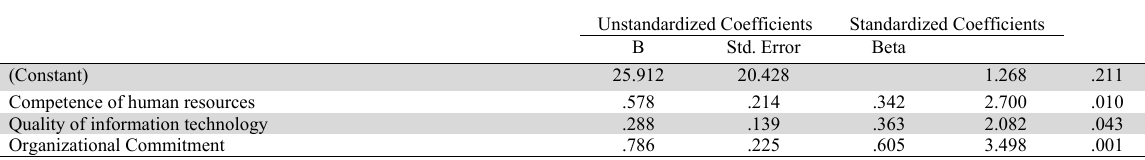
Multiple Linear Regression Test